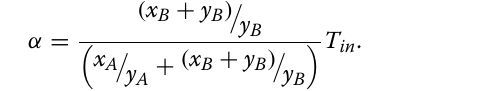
Figure 8 Calculation parameters x i and y i ( i